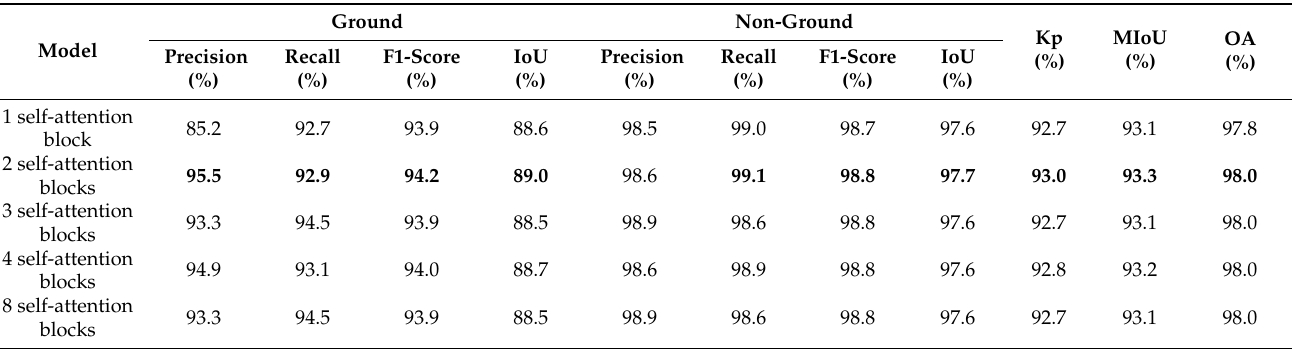
Table 6. The effect of the number of self-attention